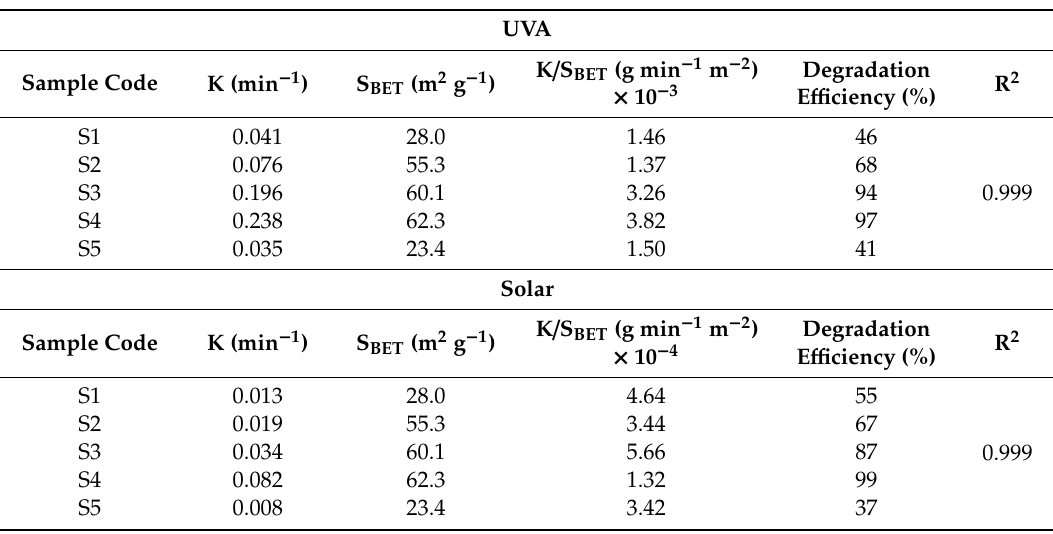
Table 2. The reaction rate constant (K), specific surface area (S BET ), reaction rate constant normalized by surface area, photodegradation e ffi ciency, and R 2 for bare TiO 2 samples (S1, S2, S3, S4, and